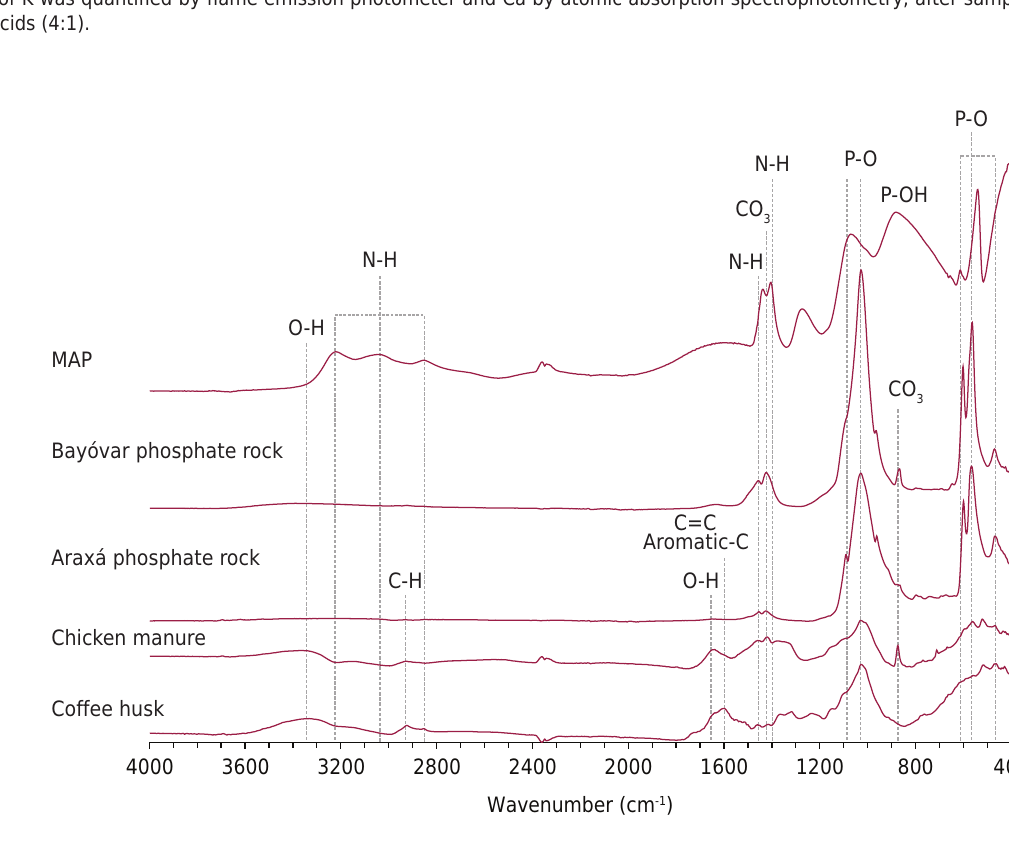
Figure 1. The ATR-FTIR spectra and the main chemical groups recorded for the coffee husk, chicken manure, Araxá phosphate rock, Bayóvar phosphate rock, and monoammonium phosphate (MAP)